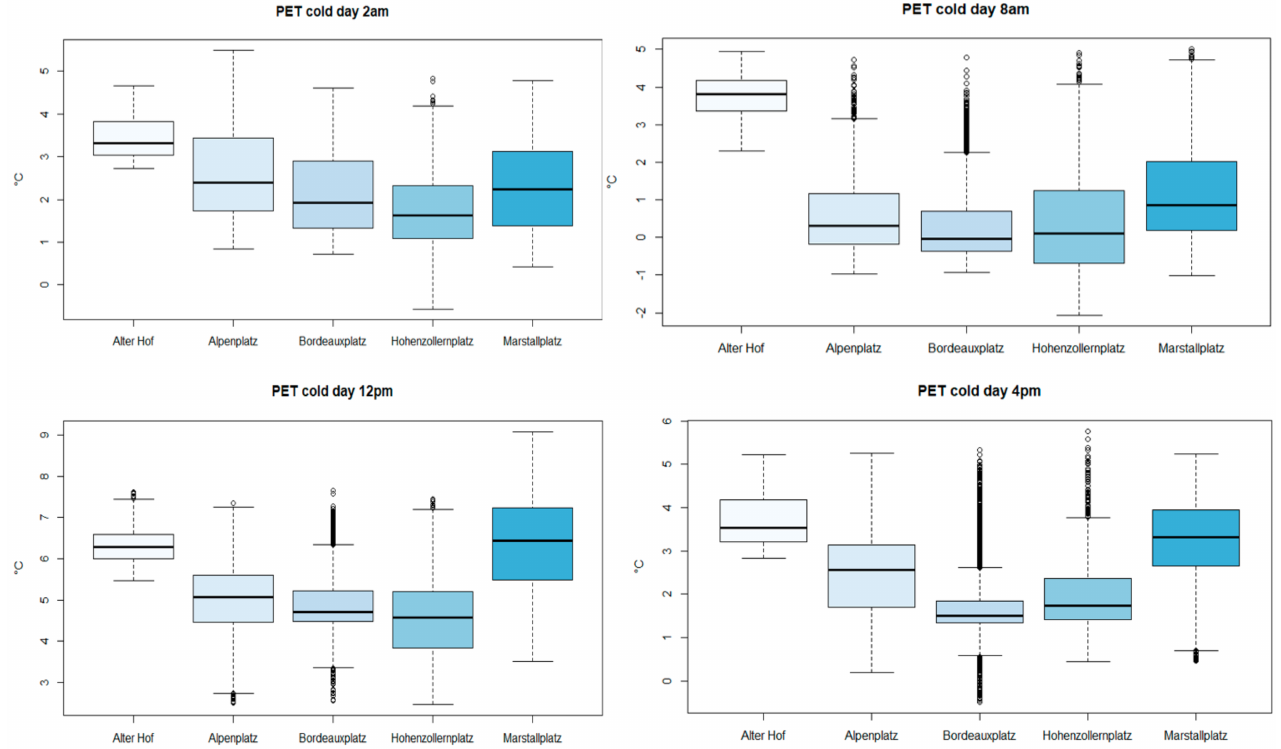
Figure 17. PET values for cold